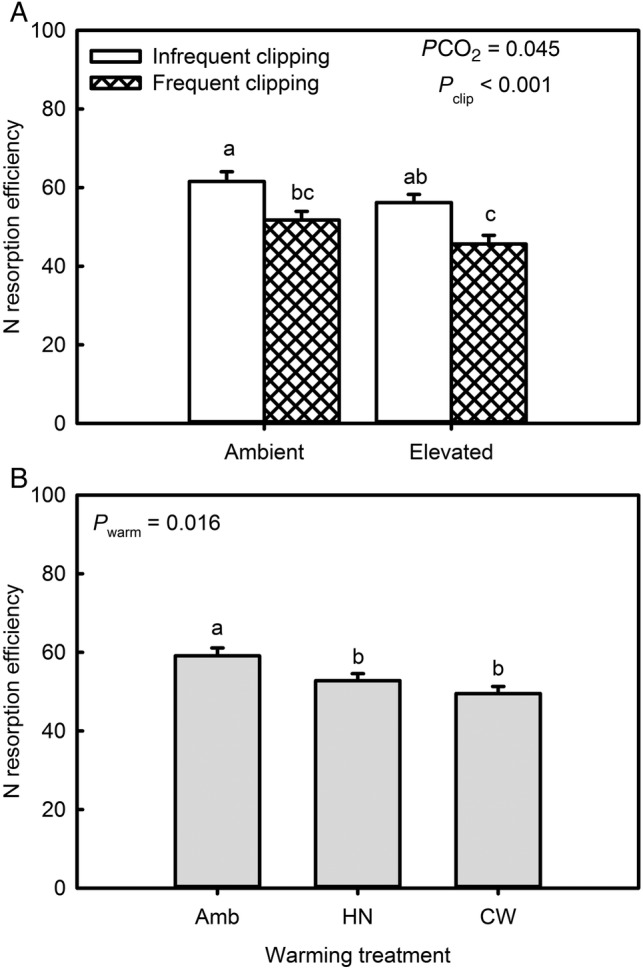
(A) Effect of clipping frequency and atmospheric CO2 concentration on N resorption efficiency. (B) Effect of warming treatment on N resorption efficiency, Amb = ambient, HN = +2.2 °C/+4.0 °C day/night warming, CW = +3.0 °C continuous warming. Different letters indicate statistically significant differences at P < 0.05 using Student's t LSD test.